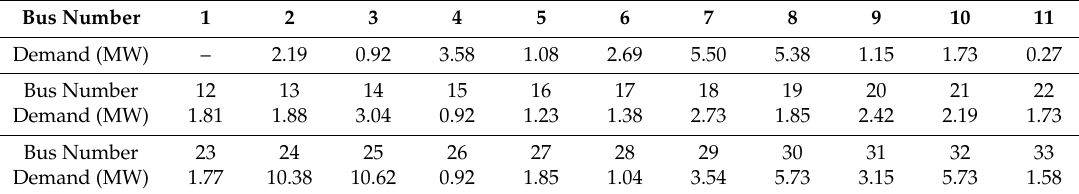
Figure 5. Forecasted load profiles of the SDN [1]. Table 3. Peak demand of loads.